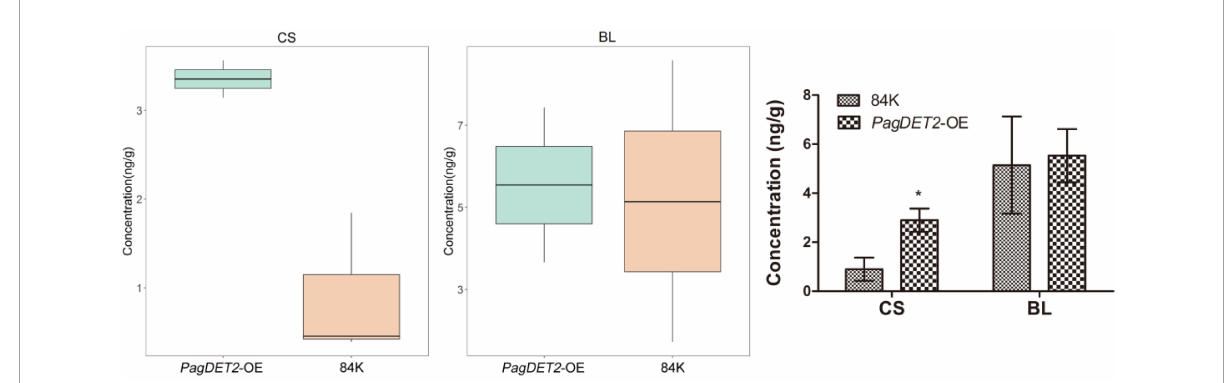
FIGURE2 The CS and BL contents of PagDET2 overexpression lines and wild-type controls. CS, castasterone; BL, brassinolide. Mean ± SD. *Indicate significant difference at P < 0.05 (Student’s t -test).